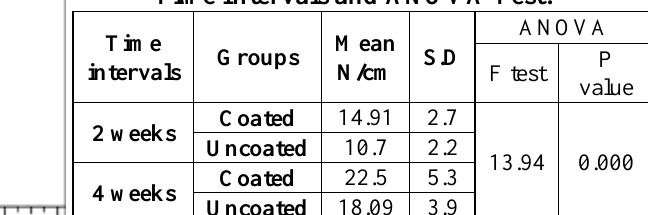
Table 1: Removal Torque Mean Values for Coated and Uncoated Implants at Different Time Intervals and ANOVA